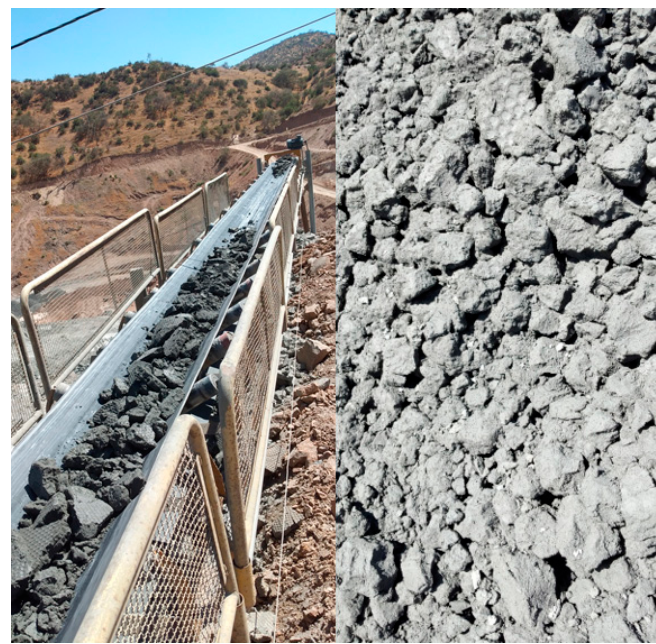
Figure 1. Filtered copper tailings in a mining company in Chile.